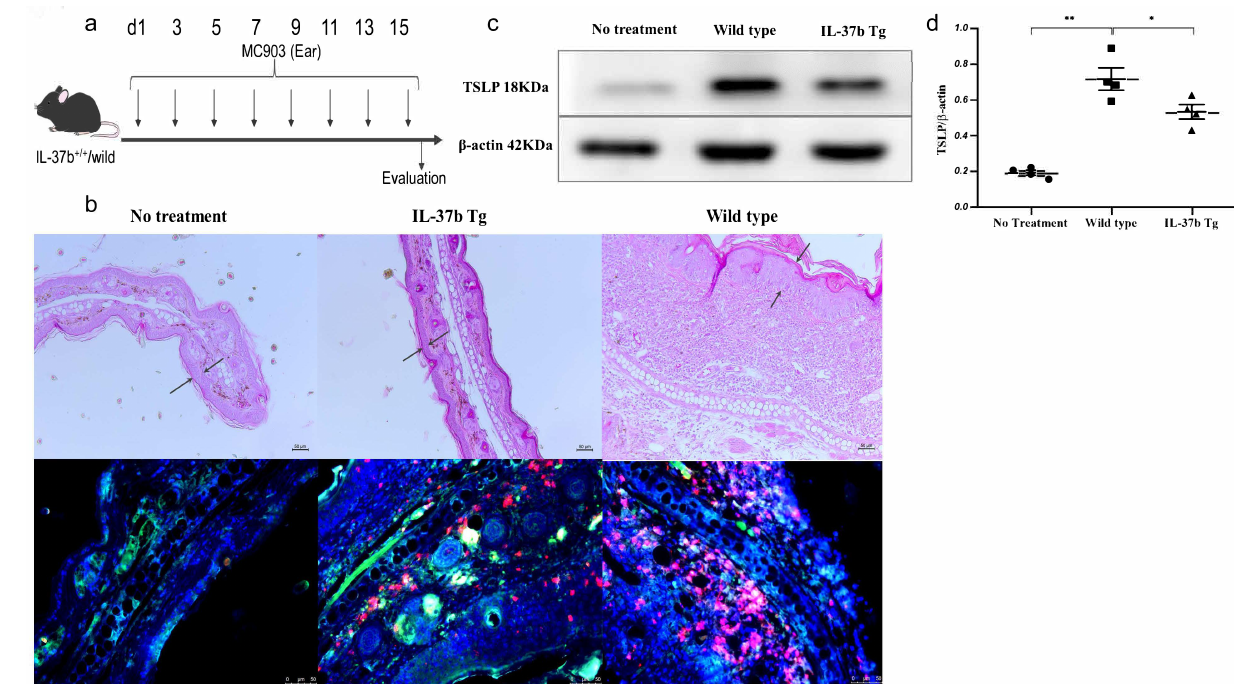
Figure 7. Effects of the IL-37b Tg (homogeneous) on AD. ( a ) AD murine model schedule; ( b ) H&E staining and immunofluo- rescence staining of MBP (red) and TSLP (green) of ear tissue; ( c ) Western blot analysis of TSLP in ear tissue; ( d ) quantitative analysis of TSLP expression. Bar charts are shown as mean ± SEM of n = 4 or 5. * p < 0.05 and ** p < 0.01 when compared between the denoted